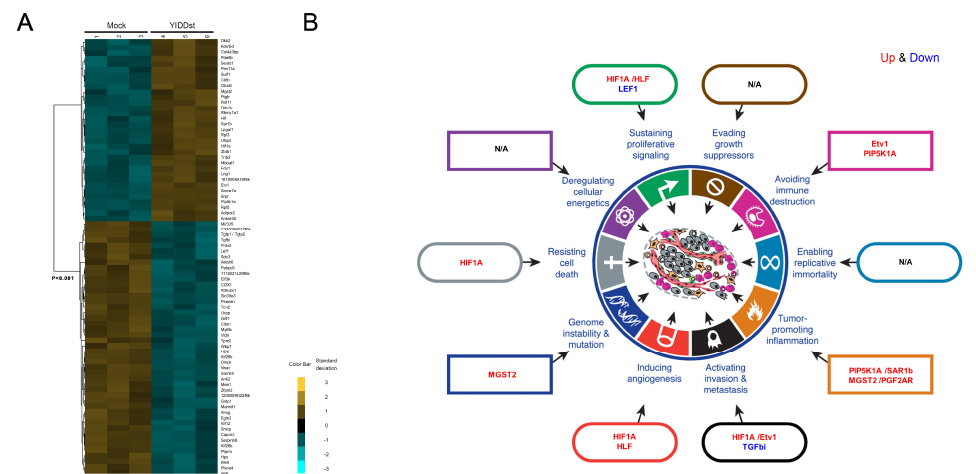
Figure 5. Di ff erentially expressed genes in YIDDst-cells. ( A ) The heatmap after analysis by Cluster 3.0 and TreeView shows the panels of up- and down-regulated genes in three pairs of YIDDst- and mock control-transfected NIH3T3 cells. ( B ) Linking the critically di ff erentially expressed genes to the hallmarks of cancer; up- and down-regulated (in red and blue, respectively) genes are annotated into di ff erent sectors of the conceptual model. Figure B was adapted from the publisher with permission. 2.4. Validation of the Di ff erentially Expressed Transcripts in Transformants with WT, Mutant, or Mock-Control by RT-qPCR